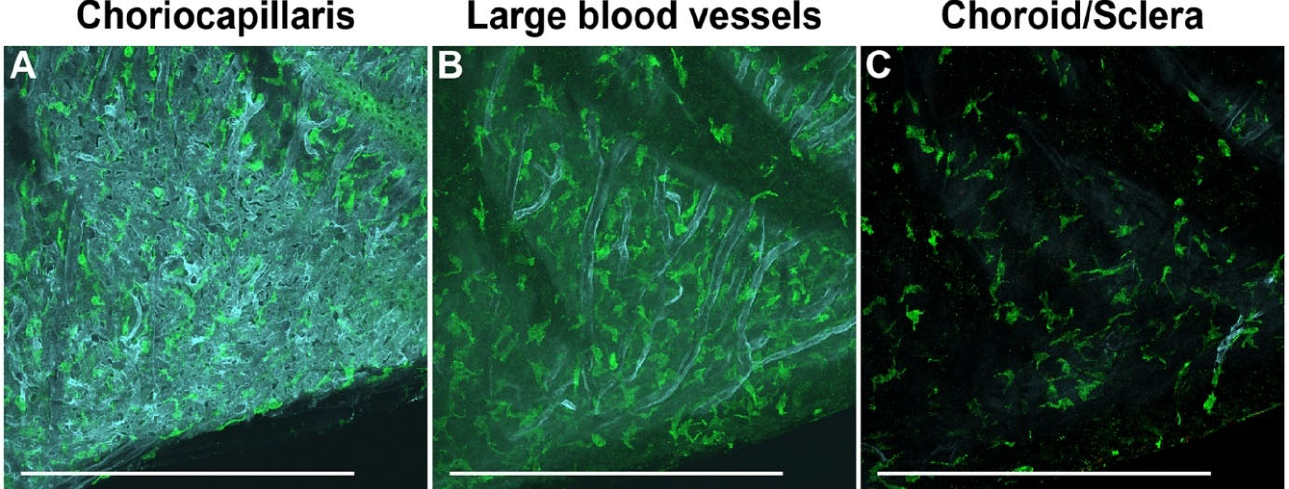
Figure 6. Visualization of macrophages in the choroid of pigmented mice. Macrophages were stained using the anti ‐ ionized calcium binding adaptor molecule 1 (Iba1) antibody. To visualize macrophages with respect to different blood vessel layers, the choroid was co ‐ immunostained with an anti ‐ podocalyxin antibody. Representative images showing macrophages throughout the choroid of C57BL/6J mice, specifically in the choriocapillaris ( A ), large blood vessel layers ( B ), and in the scleral aspect of the choroid ( C ). All representative images were from 6 ‐ week ‐ old animals and captured using a confocal microscope. Number of choroids examined = 9. Scale bars: 500 μ m.